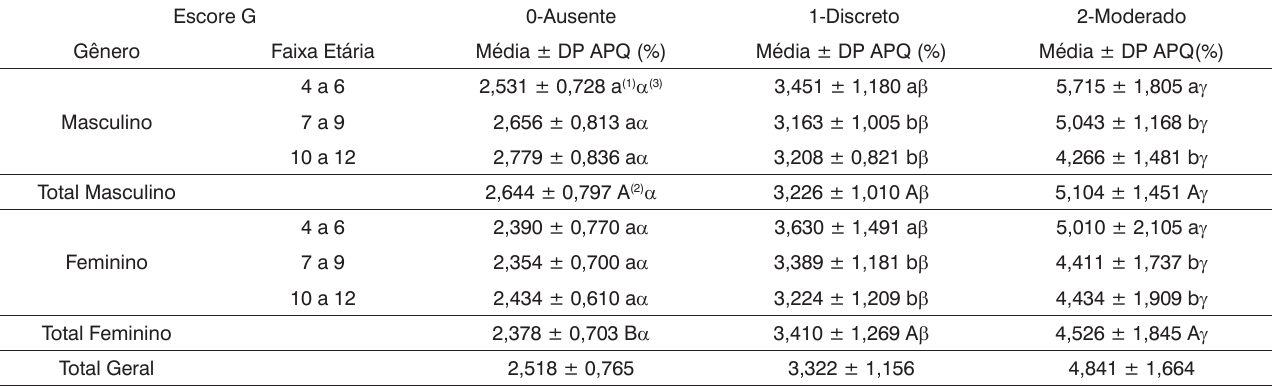
Tabela 10. Valores médios e desvio padrão (DP) de APQ (em %) e correlação com o escore do parâmetro G da escala GRBASI, o gênero e a faixa etária (em